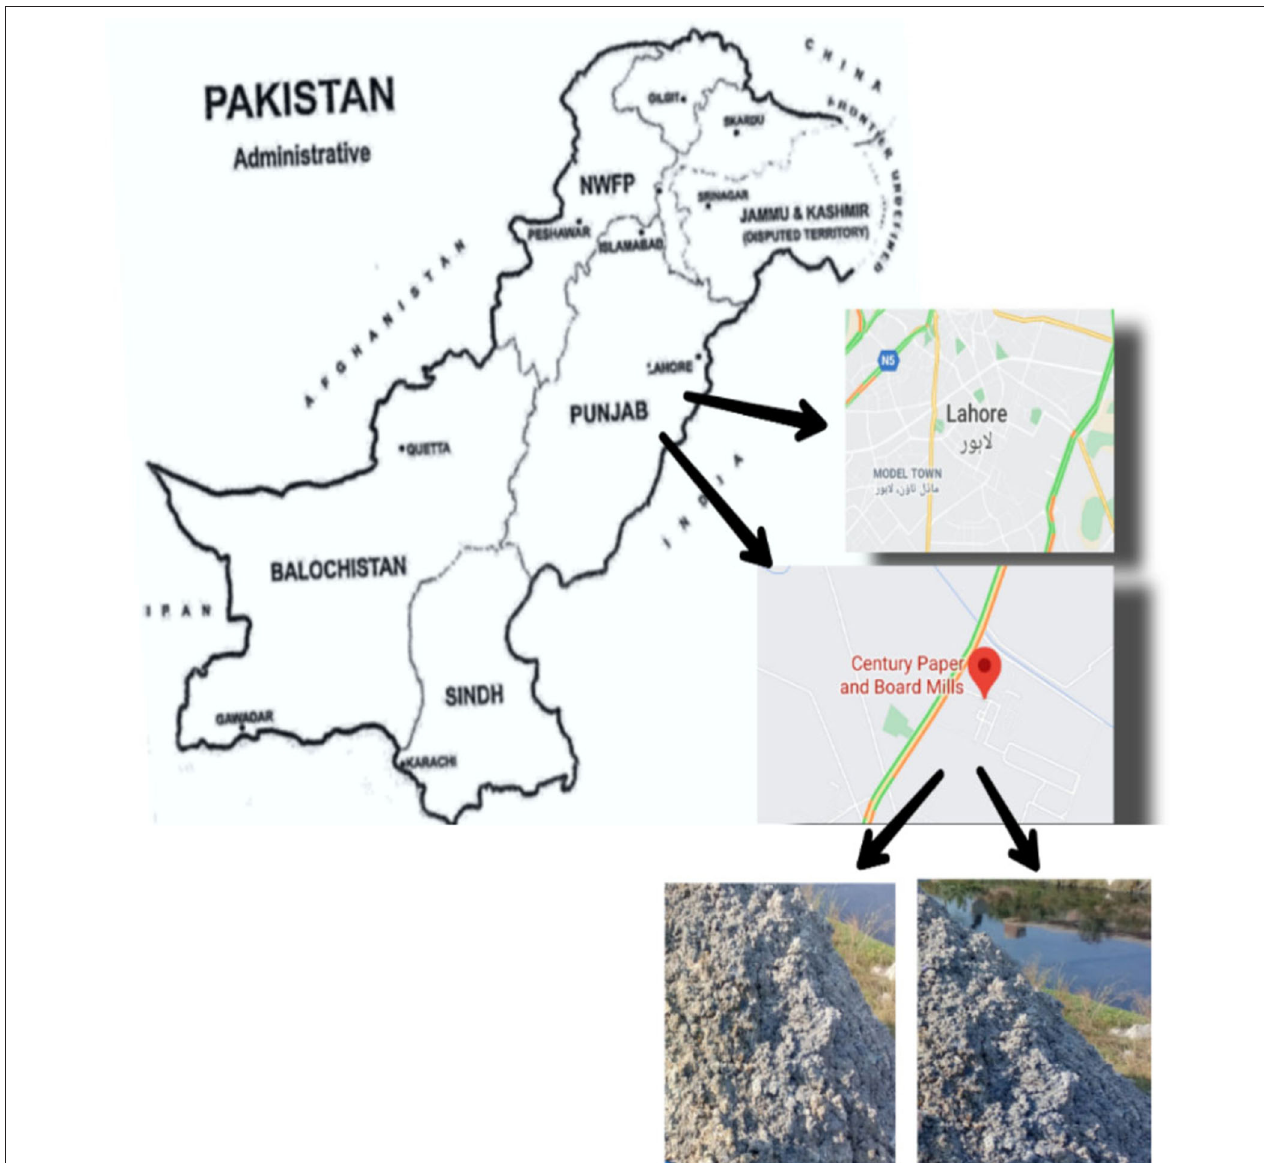
FIGURE 1 | Map of Pakistan showing sampling sites (Century Paper and Board Mill Lahore) and form of paper sludge.